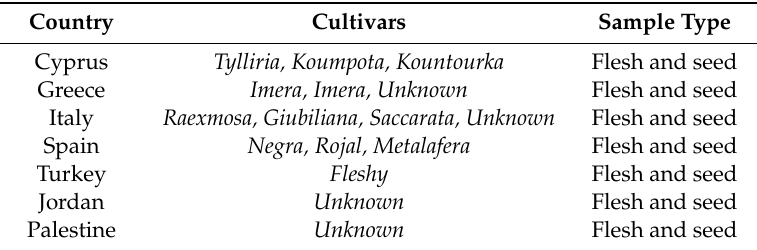
Table 4. Country of origin and cultivars of carobs. Country Cultivars Sample